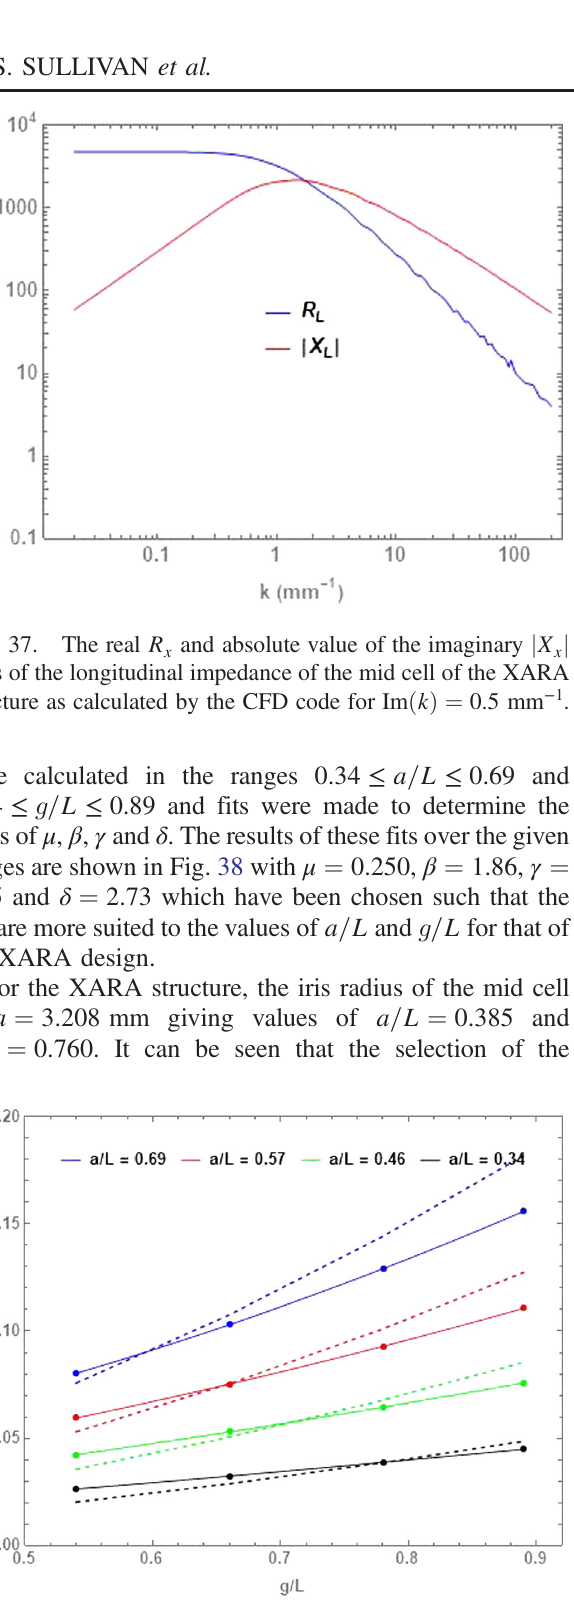
FIG. 38. Results of a parameter study to calculate s 0 for the longitudinal wake by use of the CFD code for 16 points (dots) chosen with in the ranges 0 . 34 ≤ a=L ≤ 0 . 69 and 0 . 54 ≤ g=L ≤ 0 . 89 . Interpolation of these points are shown by a solid line. A fit of Eq. (46) with μ ¼ 0 . 250 , β ¼ 1 . 86 , γ ¼ 1 . 75 and δ ¼ 2 . 73 are shown by dashed